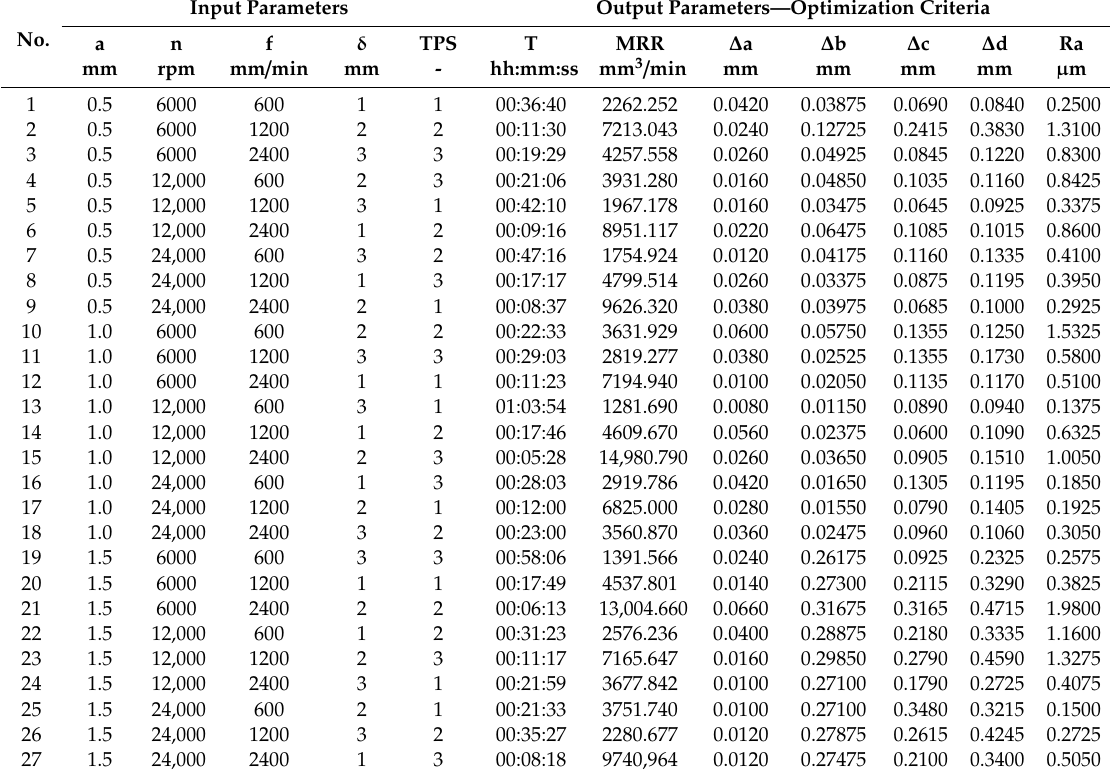
Table 2. Experimental design and the results of measurements / calculations.